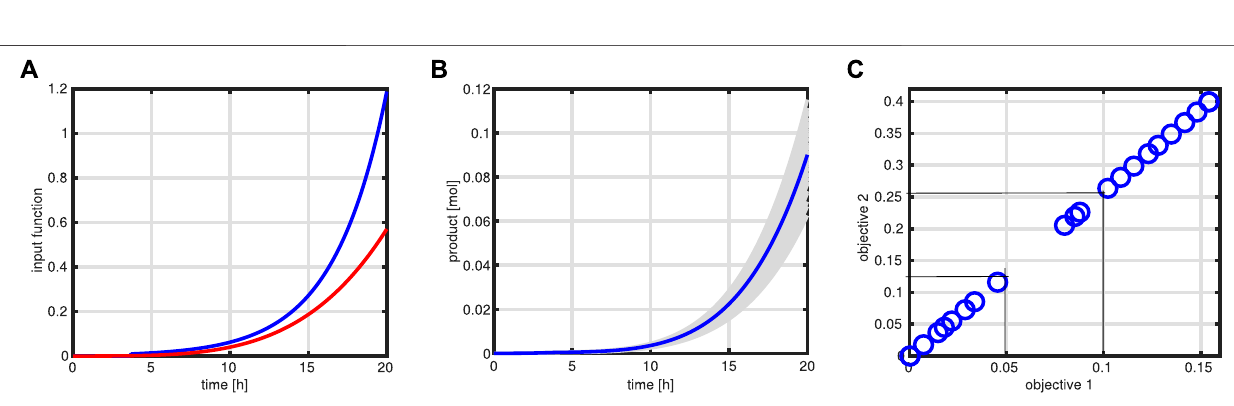
FIGURE12| Robustoptimization.Inputpro fi le(red)fortherobustcaseincomparisontothestandardcase (A) .Productcourseoftimefor100simulations(ingray) with the variation in the maximal rate of the enzymatic processes and simulation with standard parameter (blue). (B) . Pareto front for two objective functions: product amountattime t end andtotalamountofthesubstrateneededtoproducetheproduct.Thinlinesindicatethecostchangeforanincreaseinproductamountasdescribed in the text (C) .